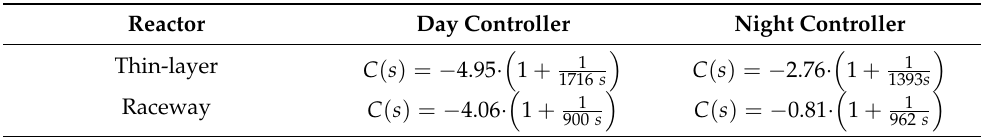
Table 2. PI controllers of the raceway and thin-layer reactors using secondary treatment wastewater as culture